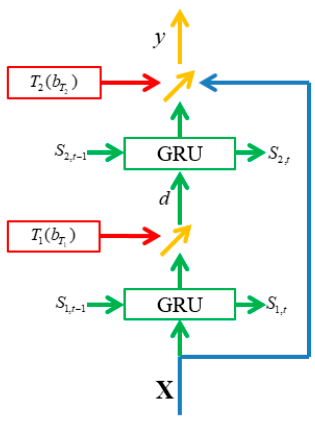
Figure 4. Illustration of GRU-based DHNs.